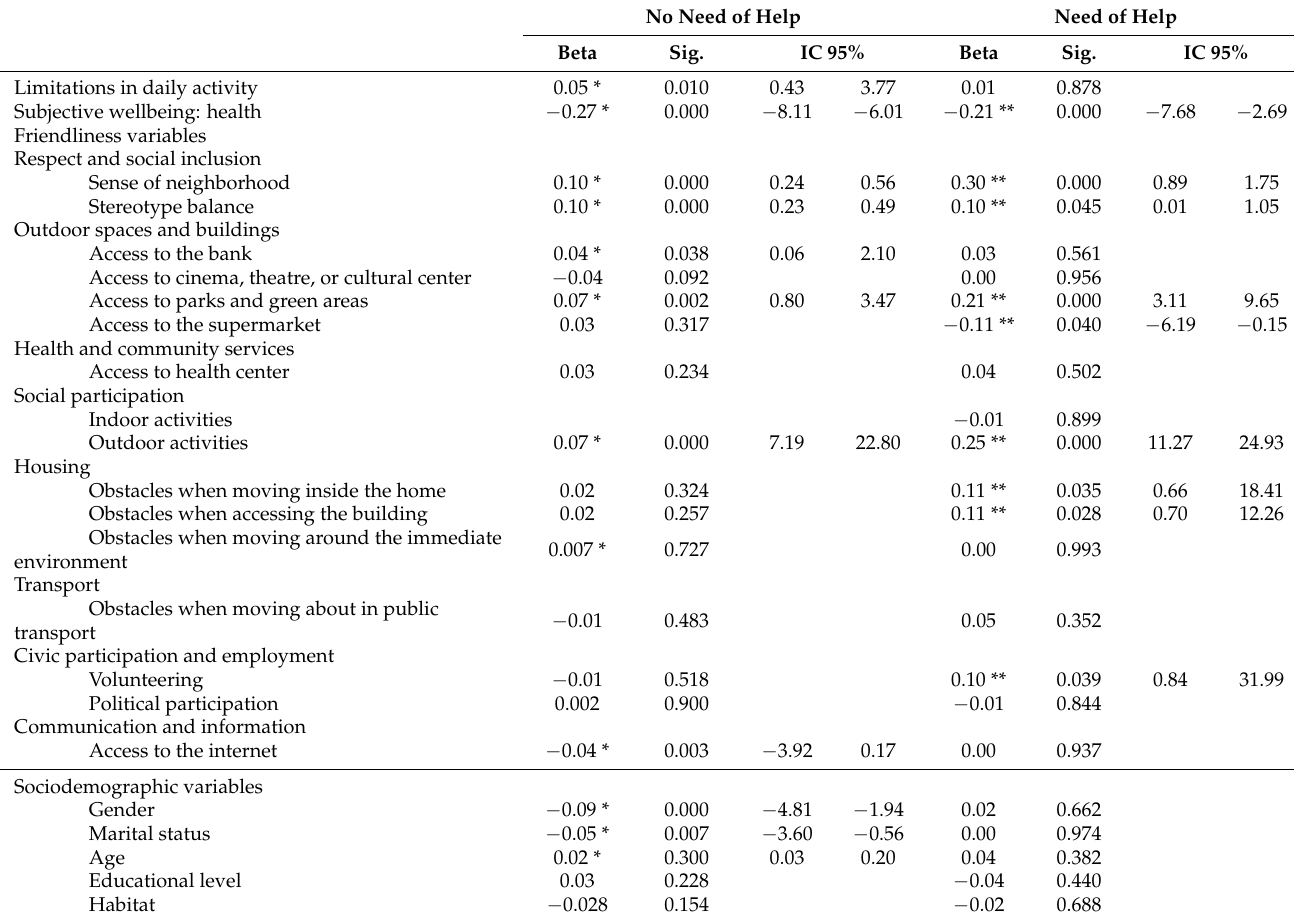
Table 2. Multivariate regression on subjective well-being (standardized regression